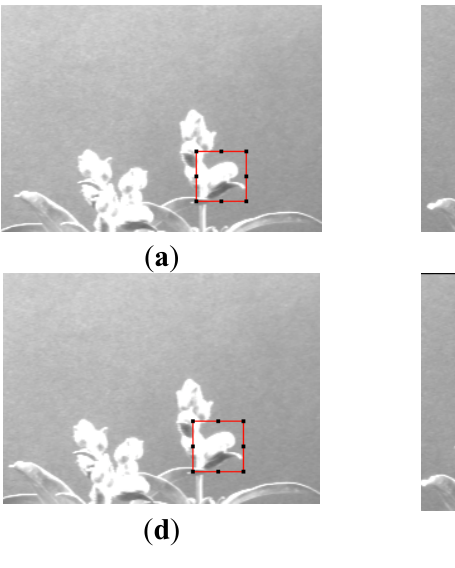
Figure 10. ( a , d ) Manual ROI selection; ( b , c ) error in ROI selection of the target; ( e , f ) Adaptive ROI selection of the